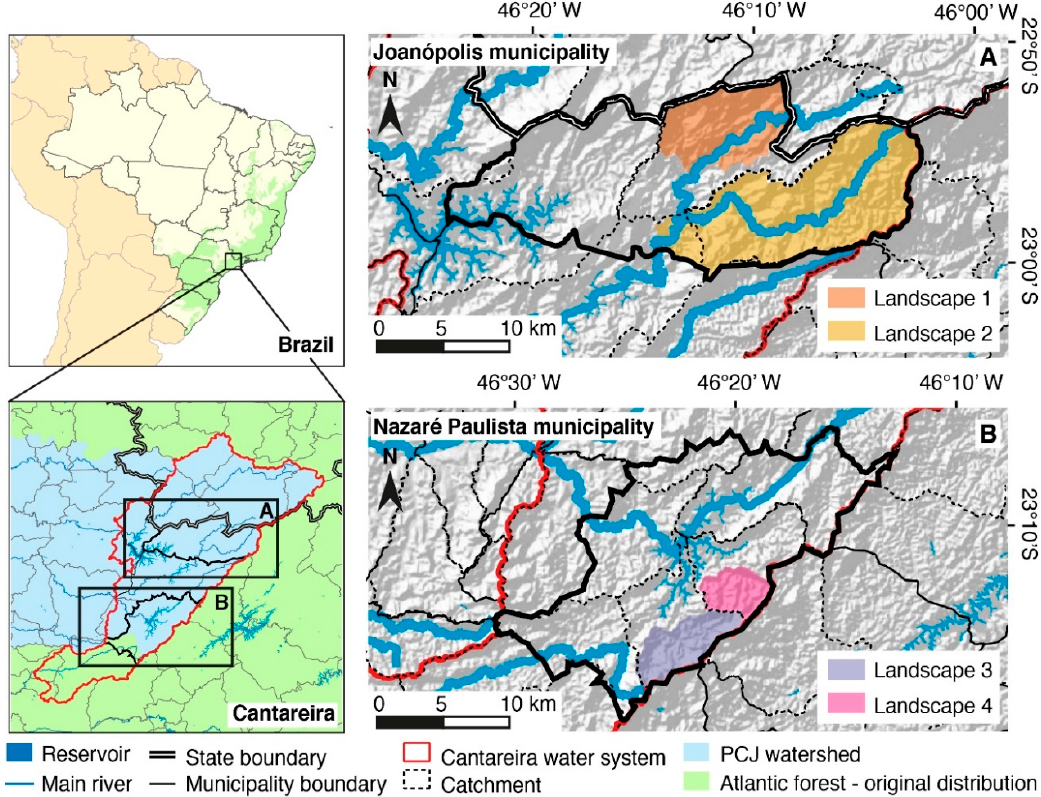
Figure 1. Landscapes involved in the Water Producer Project, located in the Piracicaba, Capivari, and Jundiai watershed, Atlantic Forest, Brazil.